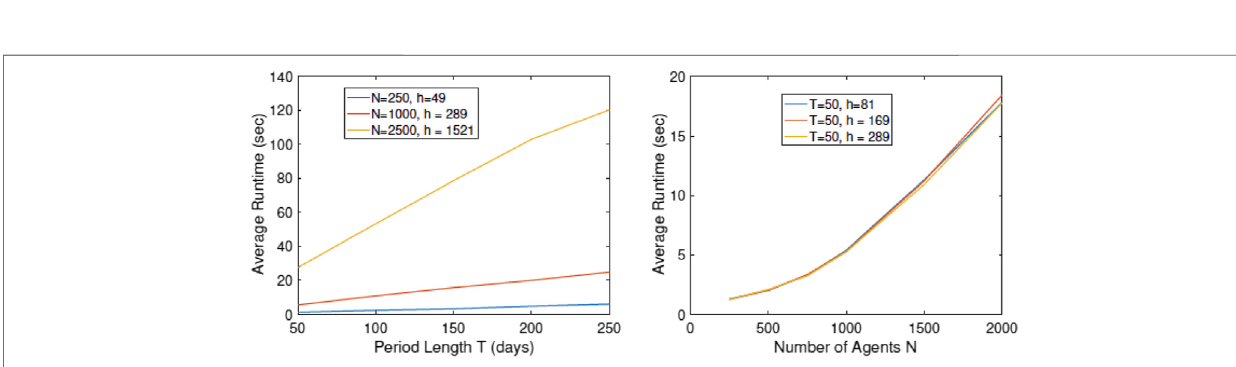
Frontiers in Applied Mathematics and Statistics |